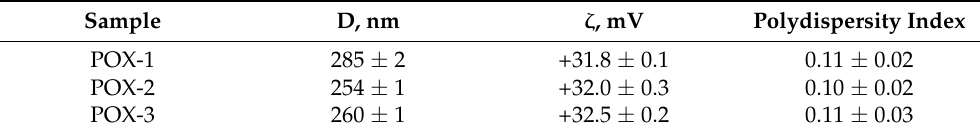
Table 1. Characteristics of the obtained